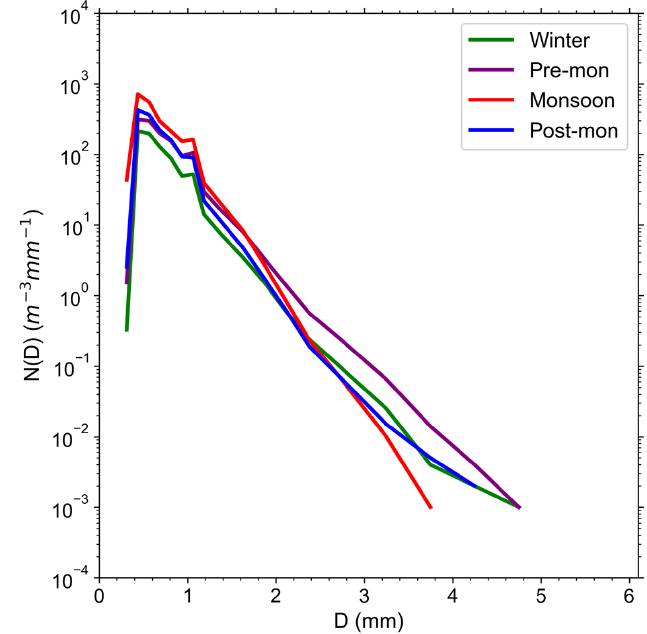
Figure 4. Averaged DSDs during the four seasons.